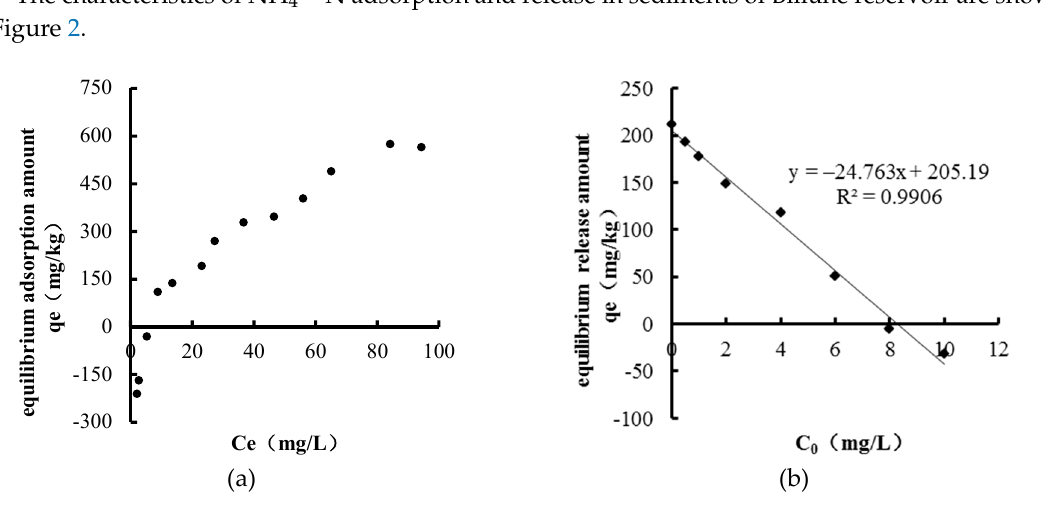
Figure 2. Characteristics of NH 4+ –N adsorption and release in sediments of Biliuhe reservoir: ( a ) NH 4+ –N adsorption characteristic; ( b ) NH 4+ –N release characteristic.